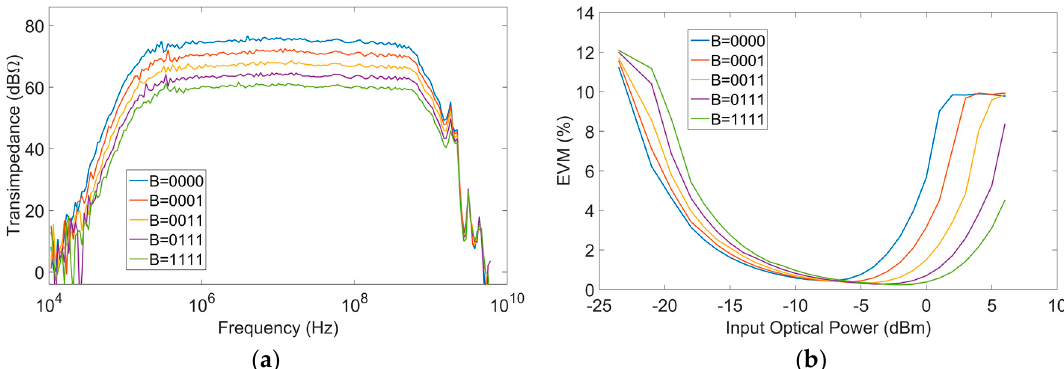
Figure 7. ( a ) Overall link frequency response and transimpedance of the TIA and ( b ) measured error vector magnitude (EVM) as a function of the input RF power for each transimpedance configuration. Data from [14].